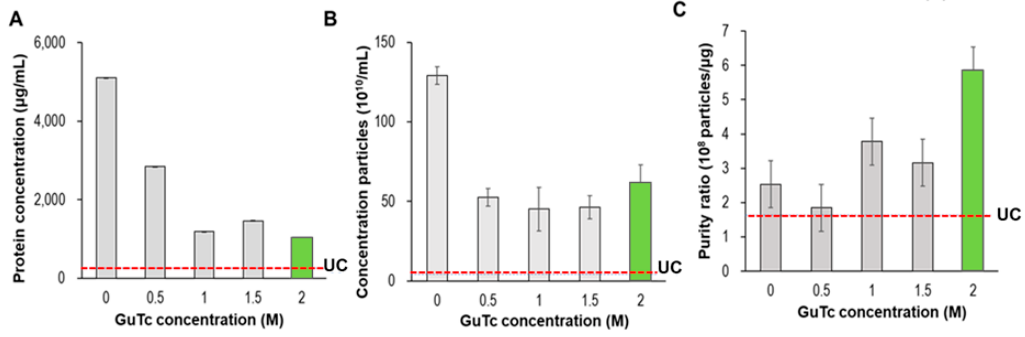
Figure 5. Comparison of GuTc concentration (0–2 M) in terms of ( A ) protein concentration, ( B ) particle concentration, and ( C ) purity ratio (particle/protein ratio).